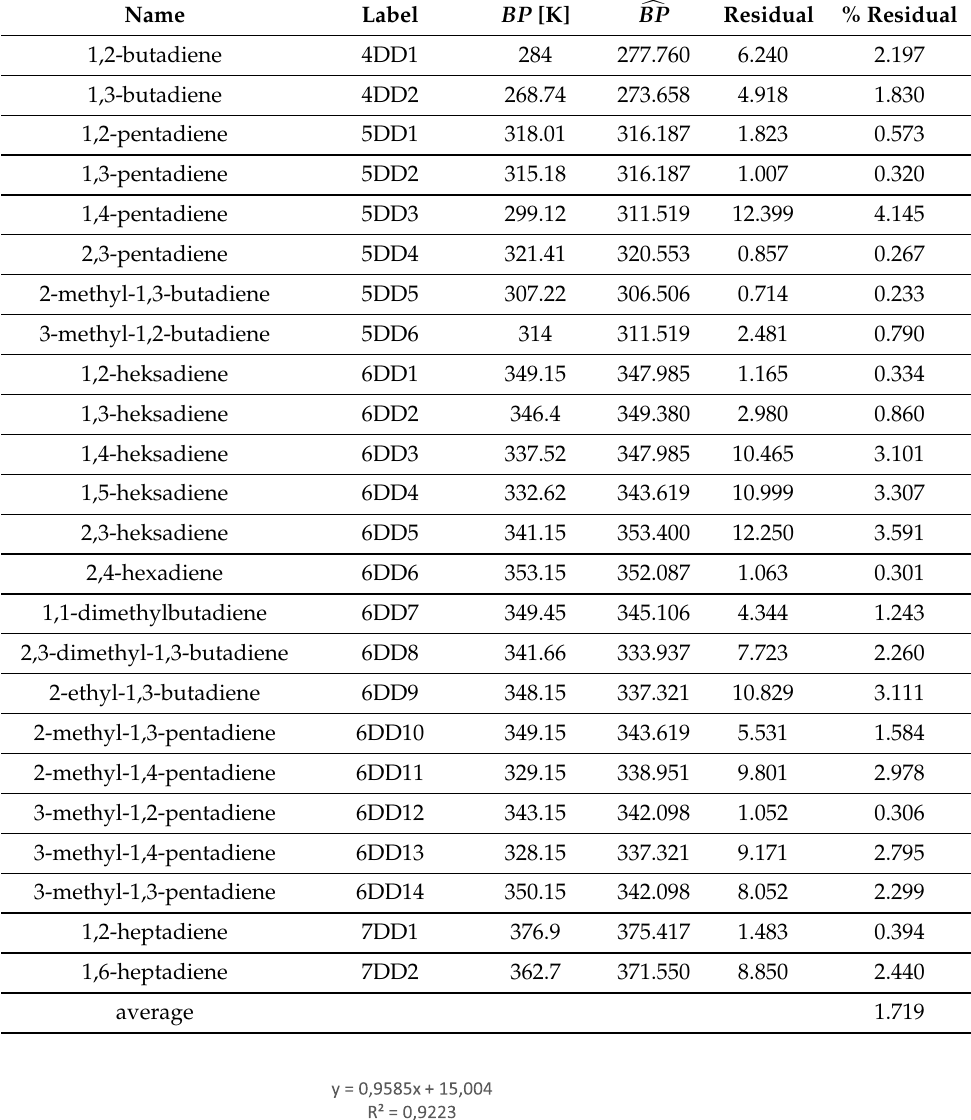
Table 7. Data for all considered alkadienes.